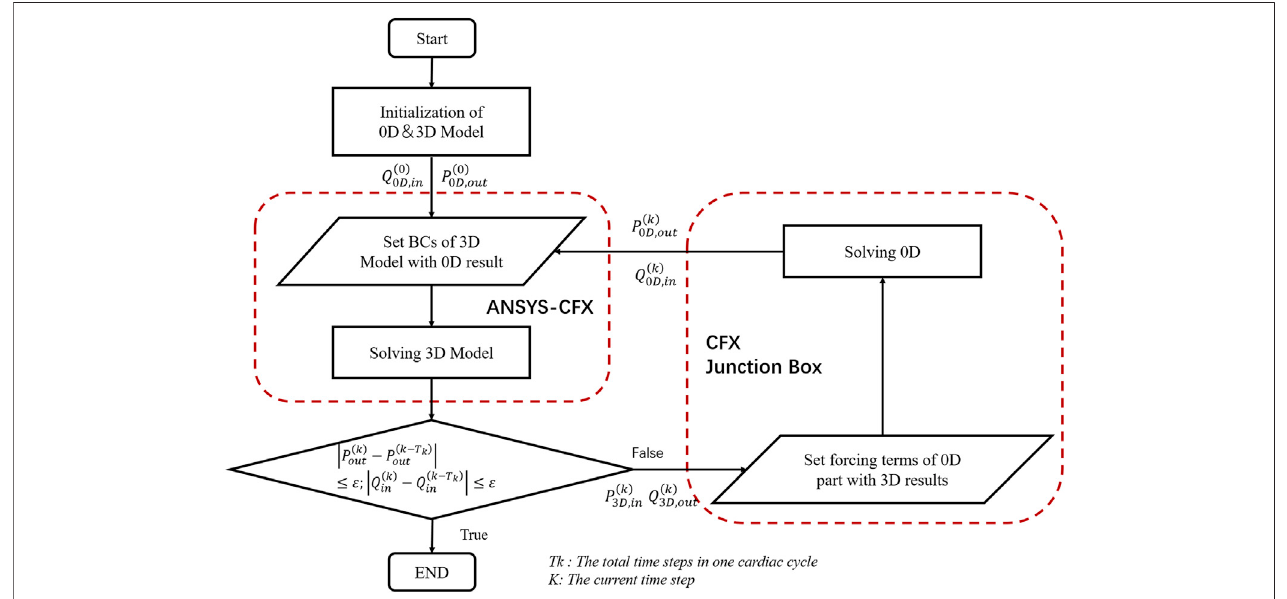
FIGURE 3| The solution fl ow chart ofthe geometric multiscale coupled model. where Q_(0D,in) represents the fl ow of the entrance at the junction ofthe 0D model andthe3Dmodel.P_(0D,out)representstheaveragepressureattheoutletatthejunctionofthe0Dmodelandthe3Dmodel.P_(3D,in)representsthemeanpressureat the inlet calculated by the 3D model. Q_(3D,out) represents the outlet fl ow calculated in 3D, and BC is short for boundary conditions. The formula in the fi gure is the coupling judgment formula of the 3D and 0D models, where ε = 0.0001.